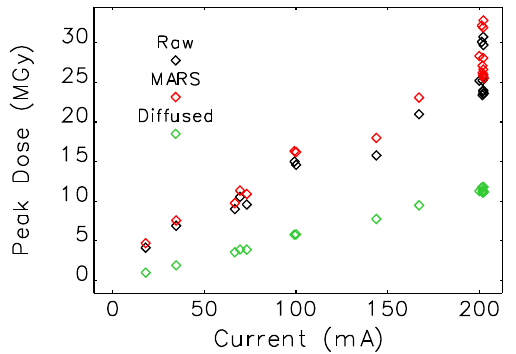
FIG. 5. Simulated peak dose in aluminum for the second collimator experiment. Shown are the raw results, MARS results, and those including thermal diffusion.